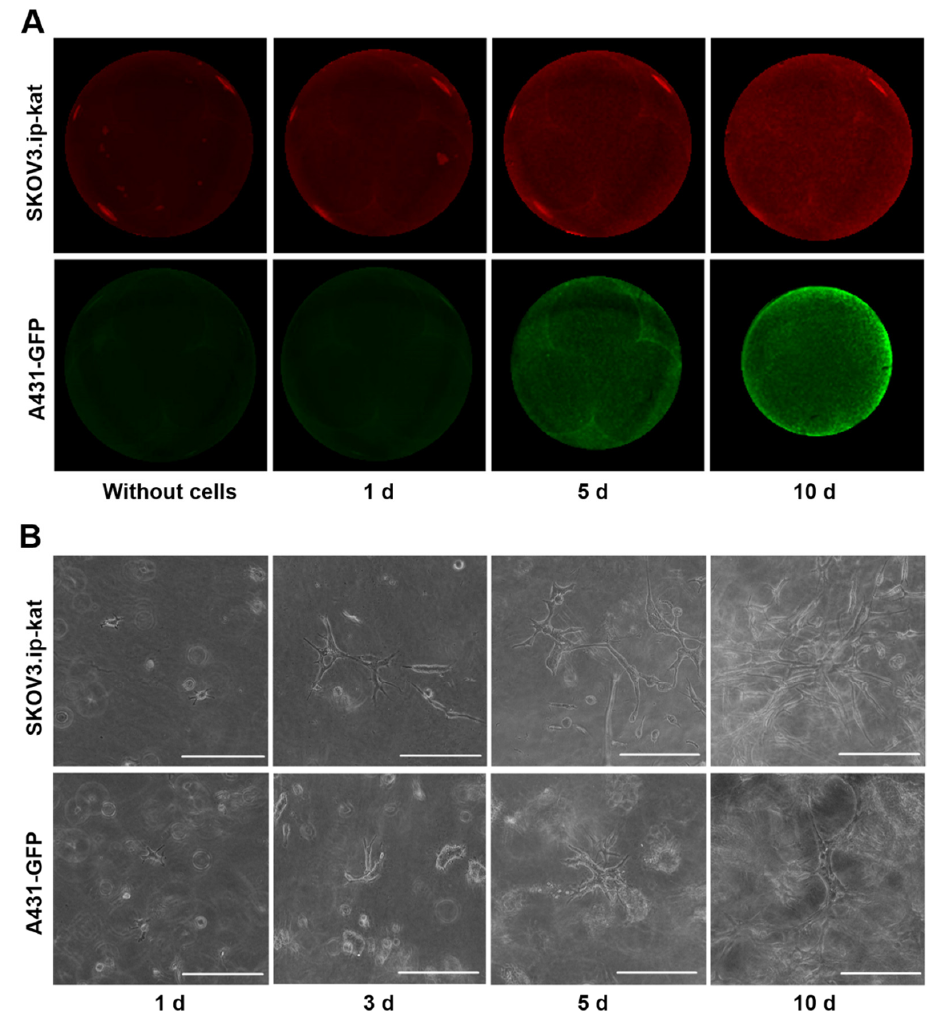
Figure 1. Growth of fluorescent cell lines SKOV3.ip-kat and A431-GFP in collagen hydrogels. ( A ) Epi-fluorescent images of control collagen hydrogel without cells and hydrogel with embedded tumor cells on days 1, 5, and 10 of the experiment. ( B ) Bright-field microscopic images of cell cultures in collagen hydrogel obtained on different days after the cells’ were embedded. Scale bar, 200 µ